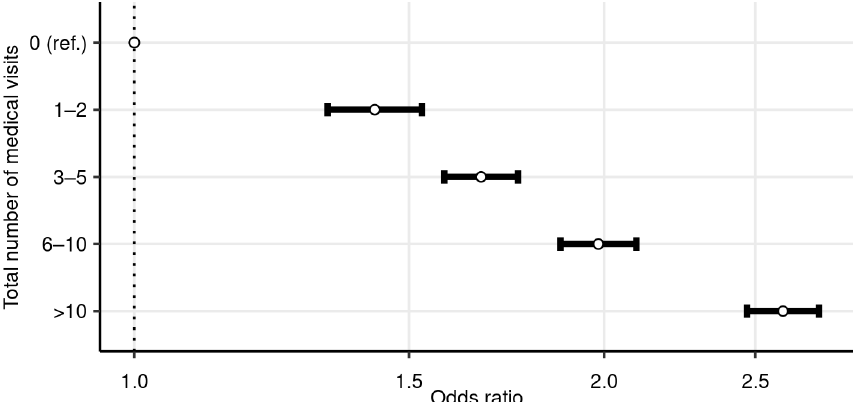
Figure 3. Logit results for dentist visits, by total number of medical visits (odds ratios with their 95% confidence intervals). Dependent variable is a binary variable indicating whether the resident has at least one dentist visit. Covariates included in the regression but not shown in the figure are sex, age group, education, occupational class, income quintile, and the number of entitlements to special medicine reimbursement. The x-axis is log-scaled. The sample size is 91,060.